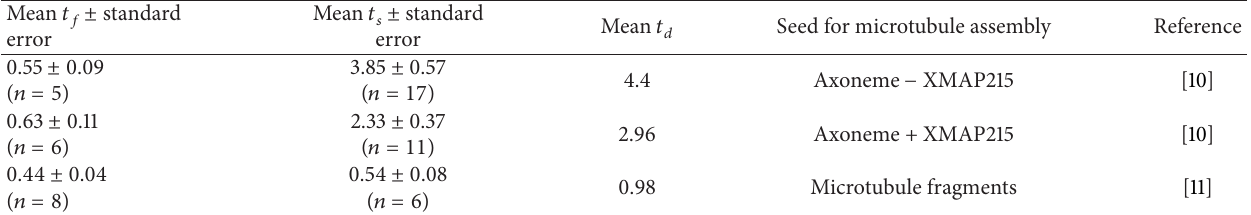
Table 1: Average durations (in second) of fast growth periods ( 𝑡 𝑓 ) and slow growth periods ( 𝑡 𝑠 ) in in vitro microtubule assembly and tubulin diffusion times ( 𝑡 𝑑 = 𝑡 𝑓 + 𝑡 𝑠 ).